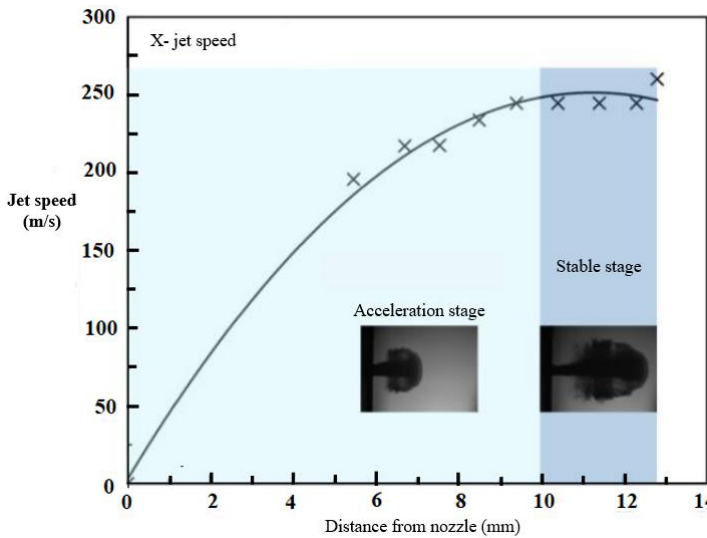
Figure 2. Changing the shape and speed of the jet with displacement.